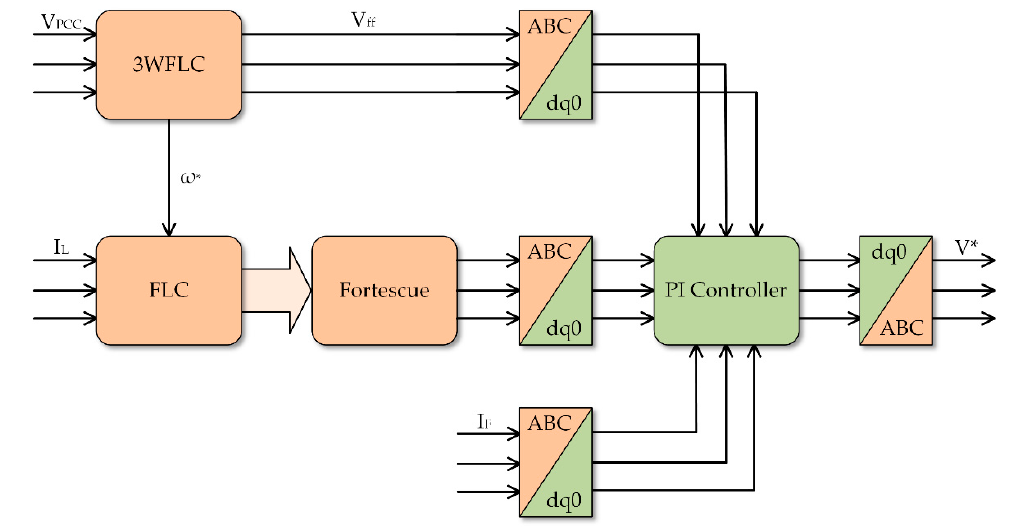
Figure 8. SAPF controller inspired in SDFLC + 3WFLC.